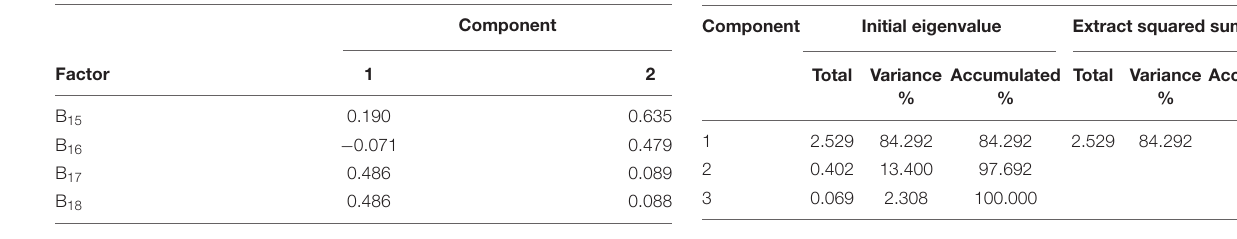
TABLE 16 | Total variance of interpretation.